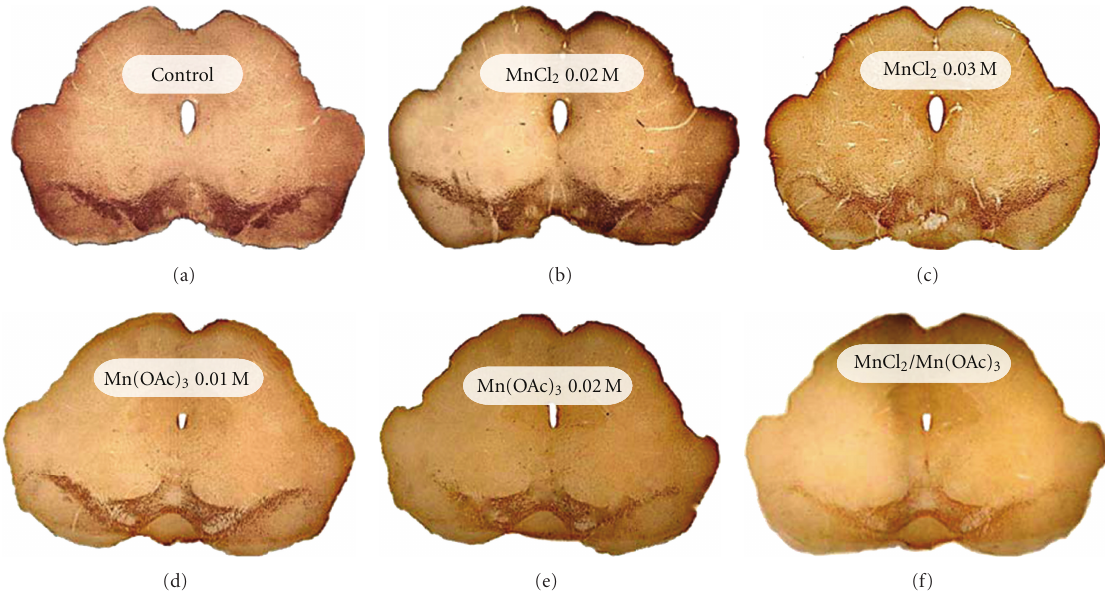
Figure 7: Pilot study. Representative coronal TH-immunostained sections through the SN and VTA of control and exposed mice to di ff erent Mn concentrations and compounds